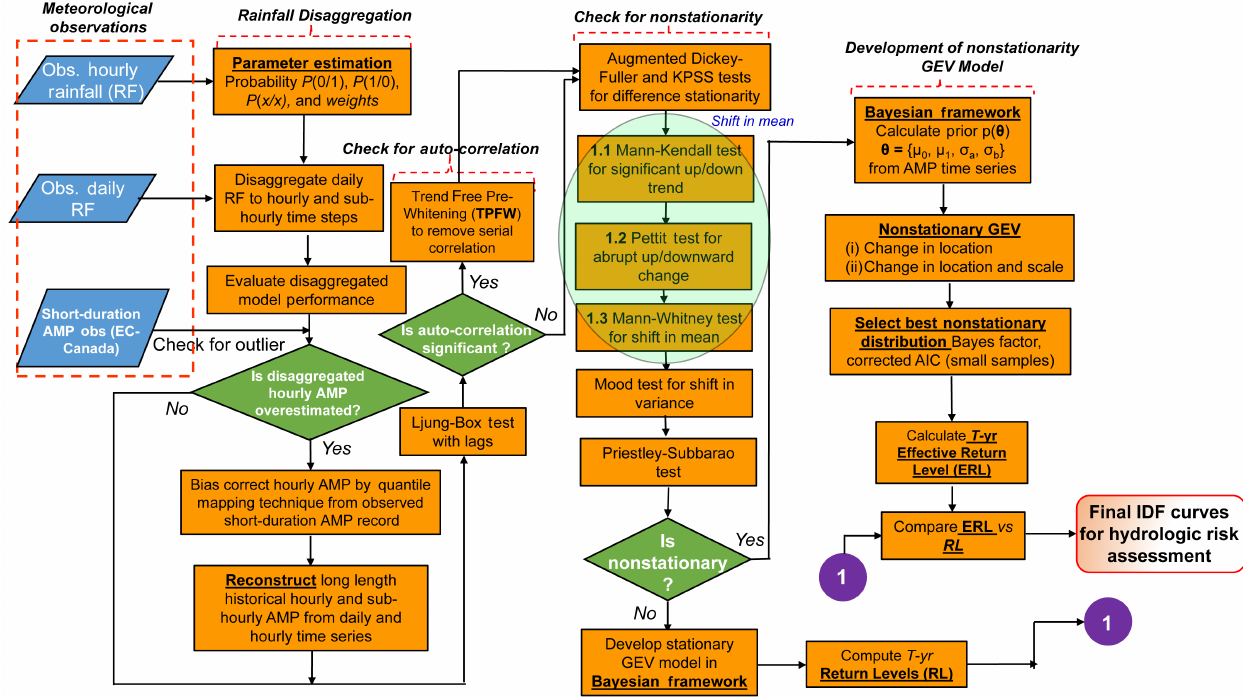
Figure 2. Schematics of the process flow (blue – input steps, orange – process steps, and green – decision steps). All three tests – Mann– Kendall, Pettitt, and Mann–Whitney – check for shifts in the mean. While Mann–Kendall checks for monotonic trends, the other two tests, Pettitt and Mann–Whitney, check for a change point or regime shift in the time